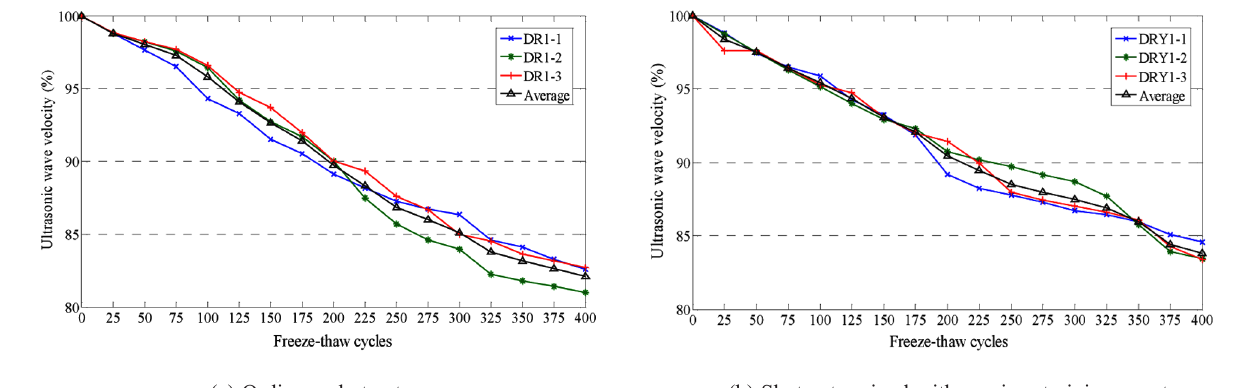
(a) Ordinary shotcrete (b) Shotcrete mixed with an air-entraining Fig. 6. Change in ultrasonic wave velocity of the shotcrete specimens during the freeze-thaw cycles